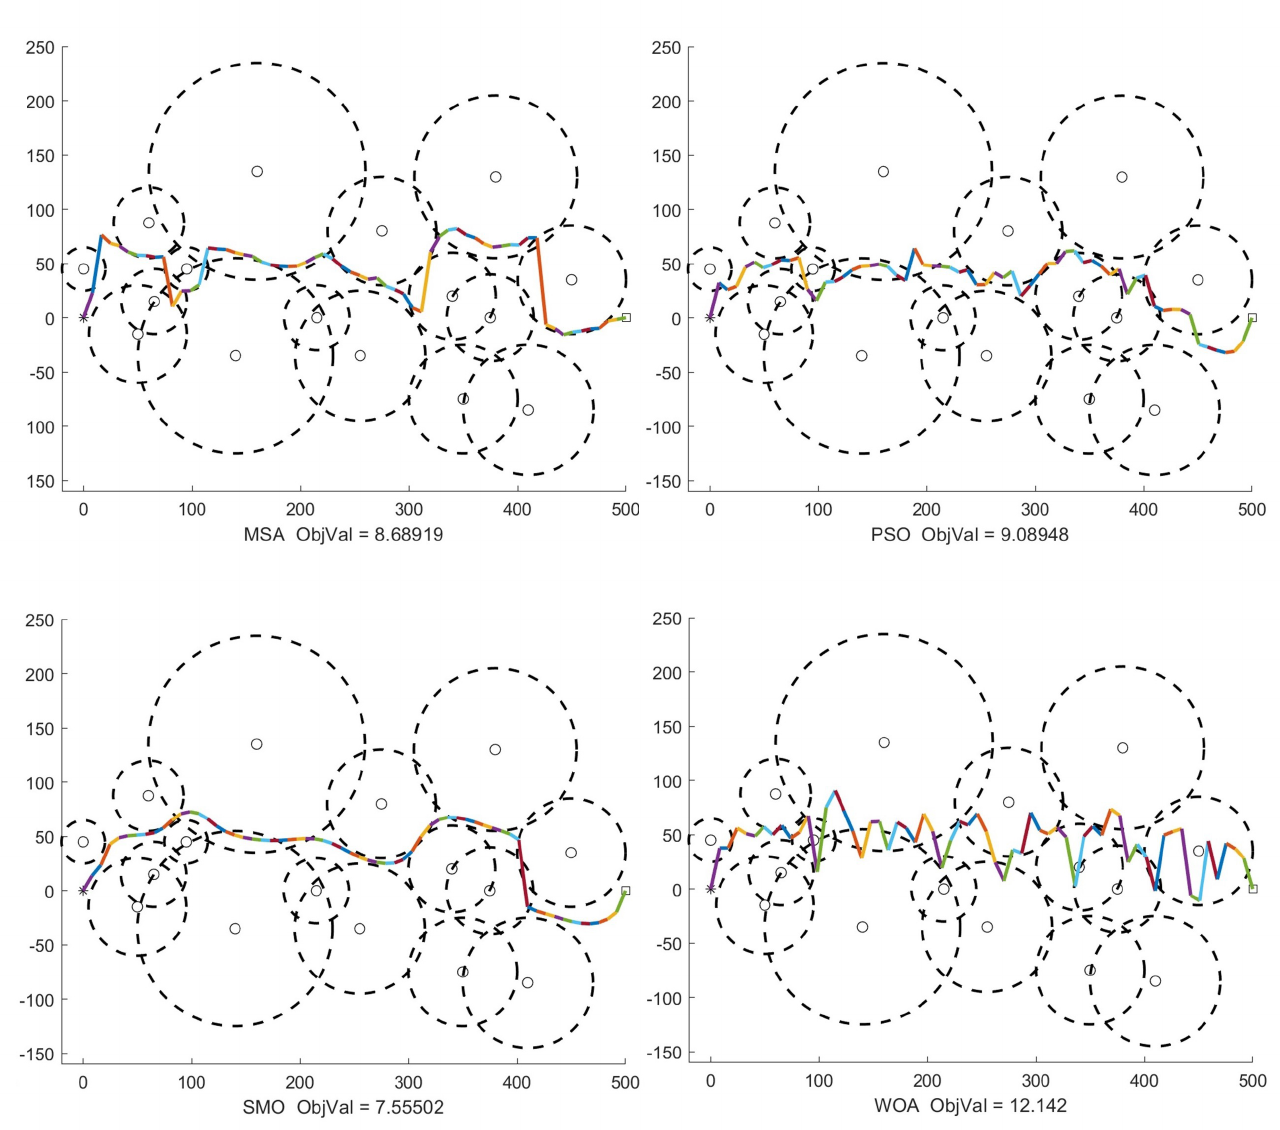
Figure 11. The comparison performance of different swarm intelligence algorithms MSA, PSO, SMO and WOA for Case 8 with D = 60, N =